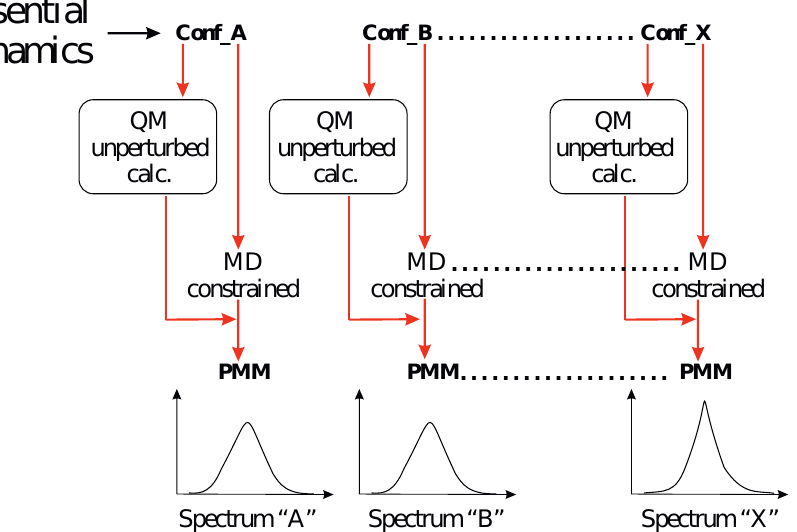
Figure 2. Schematic view of the entire computational procedure (following the MD simulation) utilized in the present work. Based on the essential dynamics analysis, a number of representative conformations (Conf) were extracted and used for (i) unperturbed quantum chemical calculations and (ii) constrained MD simulations. PMM was then applied for each of the extracted Conf for modeling the related spectra. The final spectrum was obtained by statistically weighting the